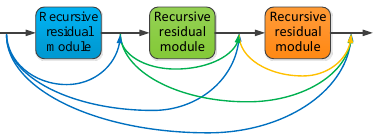
Figure 7. Structure of the high-resolution feature generation network.